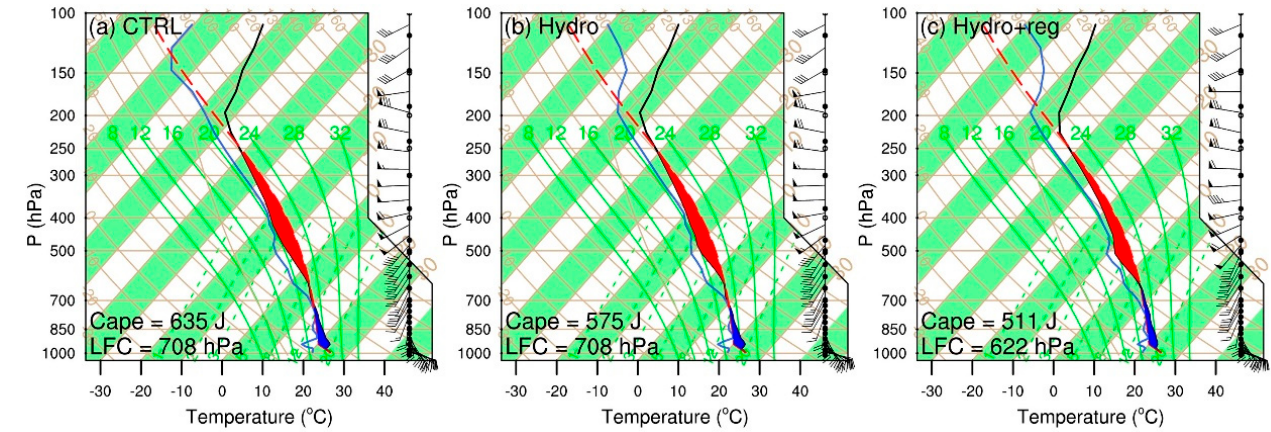
Figure 12. The Skew − T plots over (33.2°N, 119.7°E) in the initial field after 3 cycles from ( a ) CTRL, ( b ) Hydro, and ( c ) Hydro+reg experiments. The blue and the black lines indicate the dew point temperature and the ambient temperature, respectively. The shadow in red indicates convective available potential energy (CAPE).